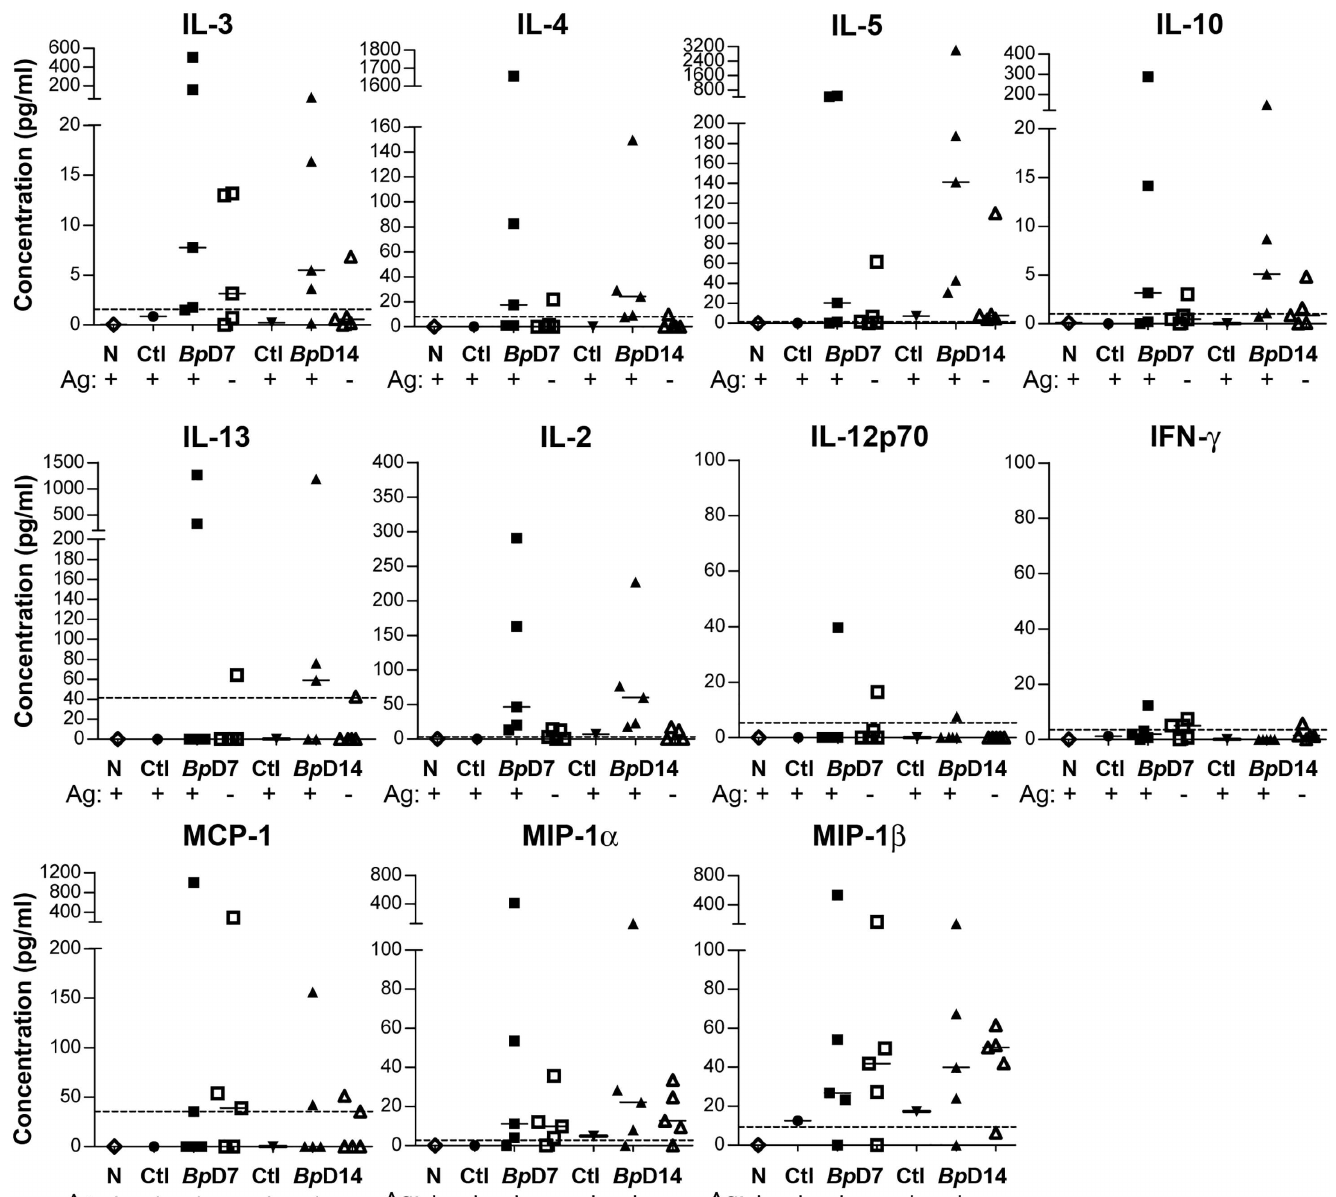
Fig 5. Cytokine production by lymph node cells after in vitro restimulation. BALB/c mice were injectedwith 50 L3 of B . pahangi into the RHS footpad and with HBSS into the LHS footpad. PoplitealLN cells were collected from infected limbs of individualmice at d7 ( Bp D7)and d14 ( Bp D14) post-infection and pooledfrom uninfectedlimbs (Ctl, ● d7, ▼ d14p.i.) or naive mice (N). Cells were re-stimulated with media (-) or 10 μ g/ml Brugia antigen(+) as indicatedfor 48 h at 37˚C, and the cytokine and chemokine productiondetermined by Luminexassay. Valuesfor individualmice are shown in samples from infected limbs and lines represent median values. The dotted line in each graph shows the limit of